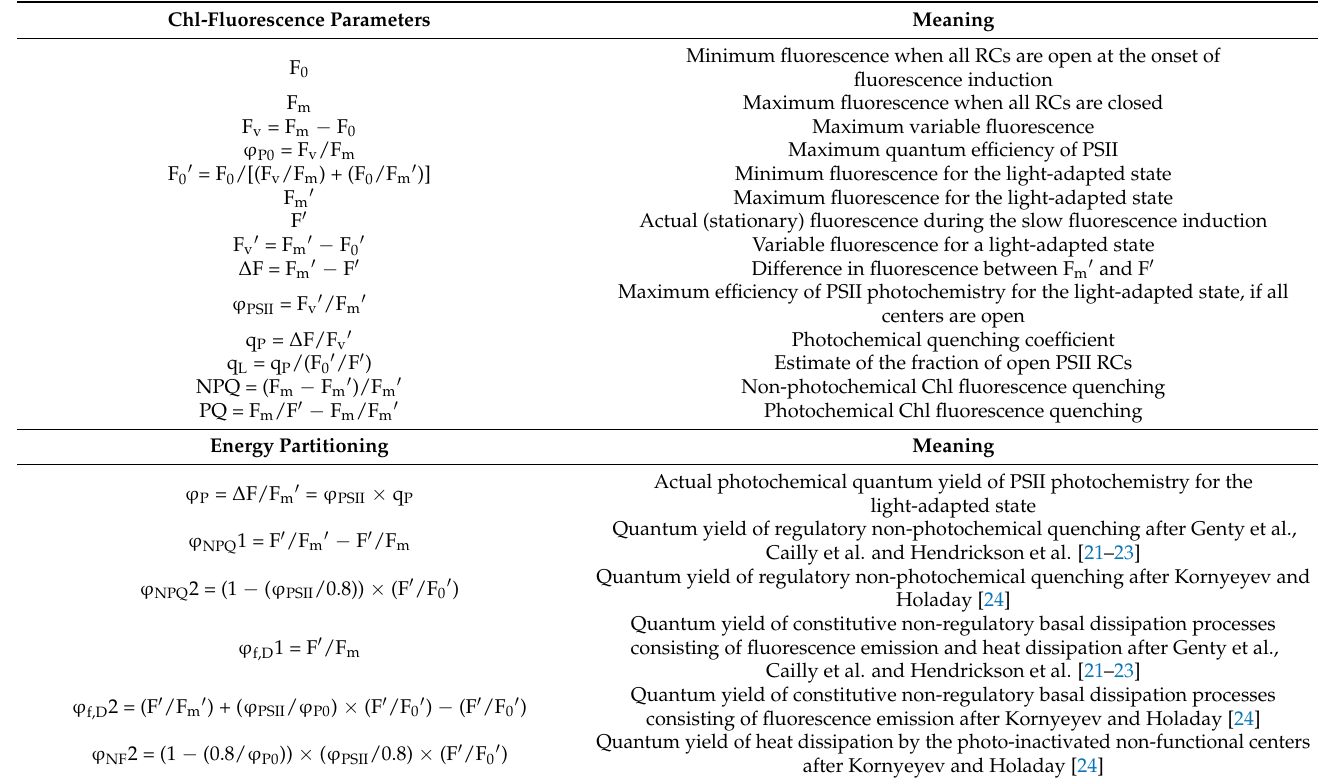
Table 1. Definition of fluorescence parameters of the saturation pulse and steady-state fluorometry after Oxborough and Baker [18], Murchie and Lawson [19] and Laz á r [20]. Chl-Fluorescence